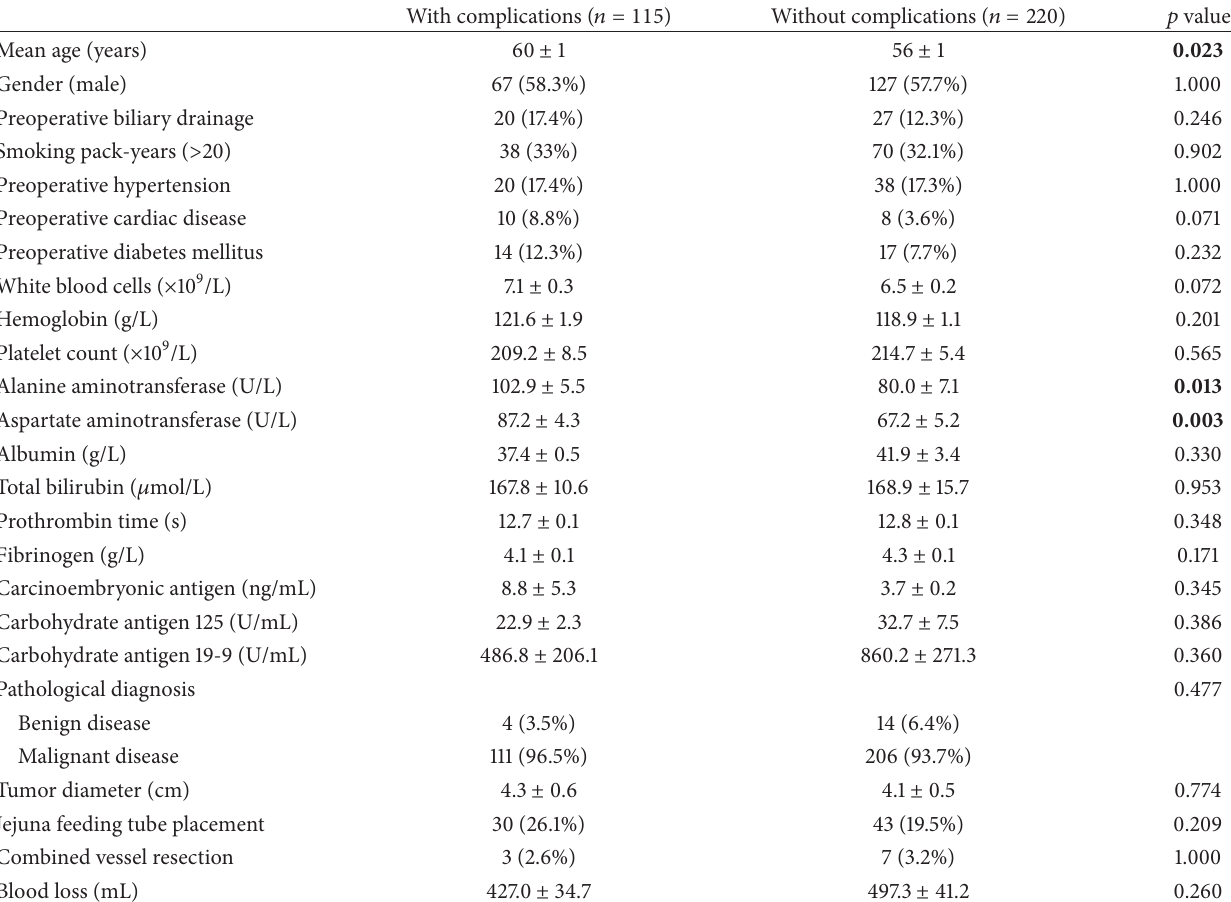
Table 3: Potential risk factors contributing to postoperative complications after